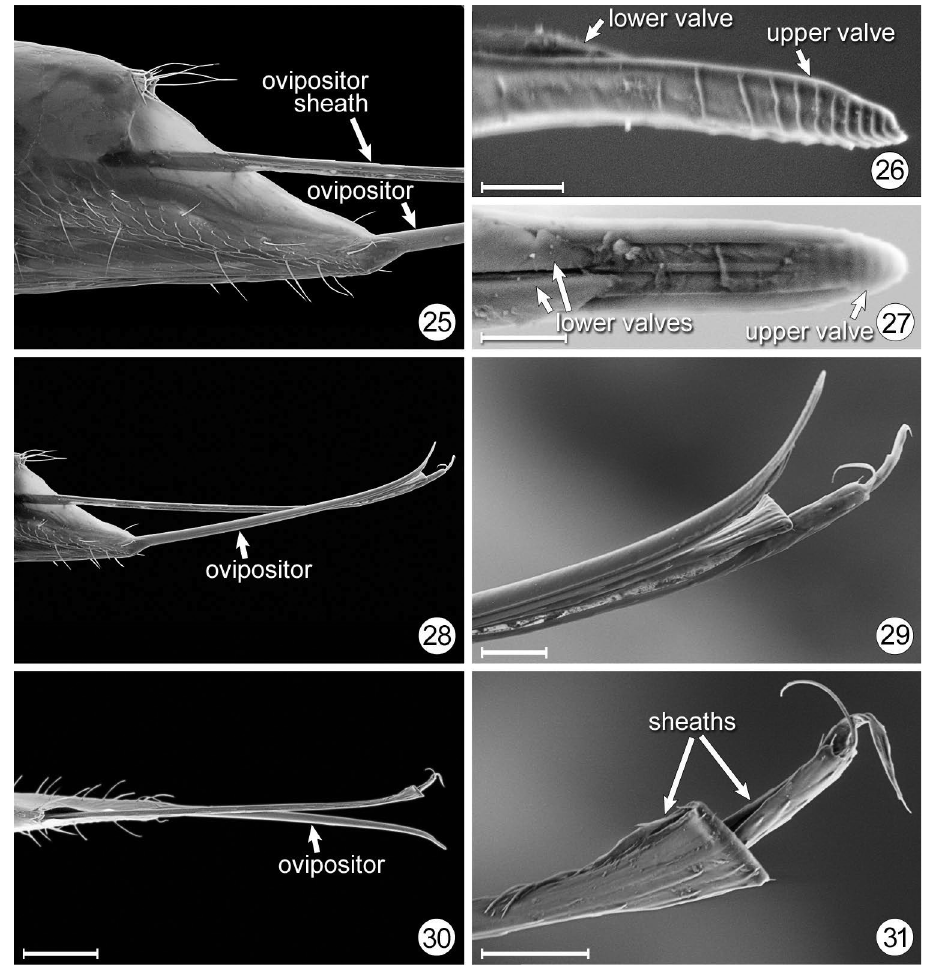
Figures 25–31. Eustochomorpha haeckeli , female. 25 gaster apex, lateral 26 ovipositor apex, dorsal 27 ovipositor apex, ventral 28 ovipositor + sheaths, lateral 29 apex of ovipositor + sheaths, lateral 30 ovi- positor + sheaths, dorsal 31 apex of sheaths (one sheath folded over on itself). Scale bar for 25 = 50 μm; 26, 27 = 5 μm; 28, 30 = 100 μm; 29, 31 = 20 μm.